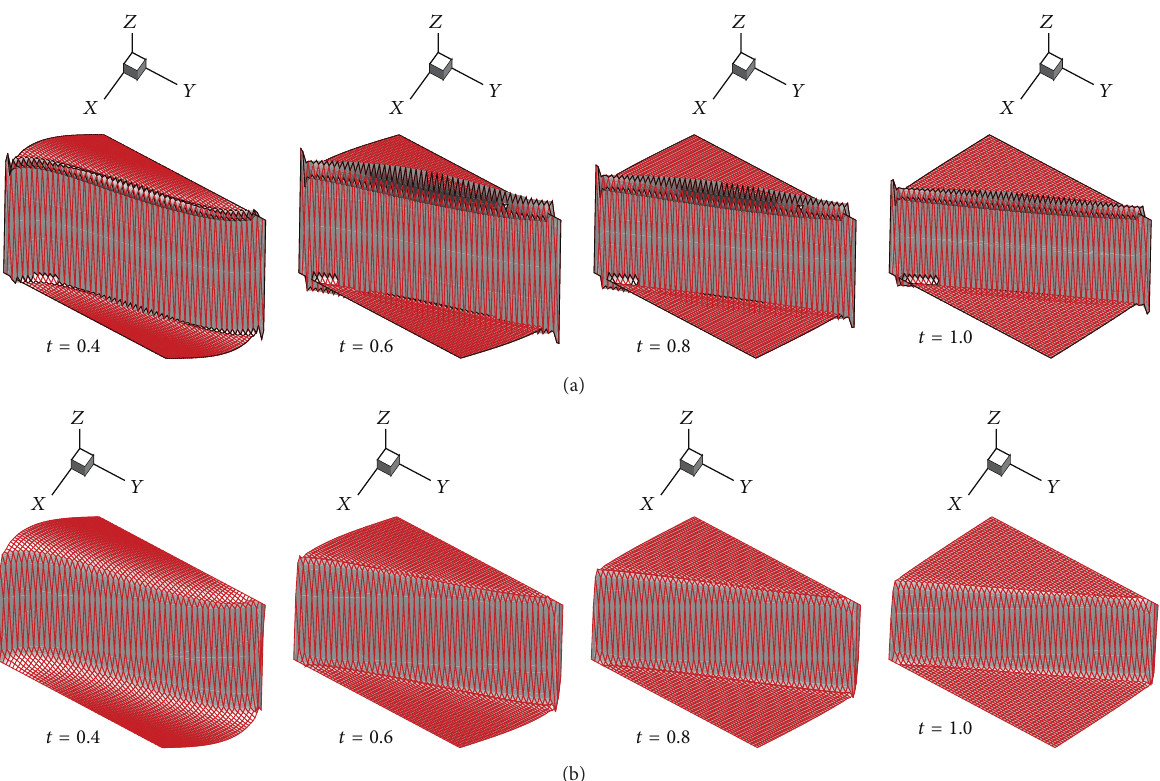
Figure 9: 2D Burgers’ equation for Re = 10 3 . (a) are computed without filter; (b) are with the low-pass filter.